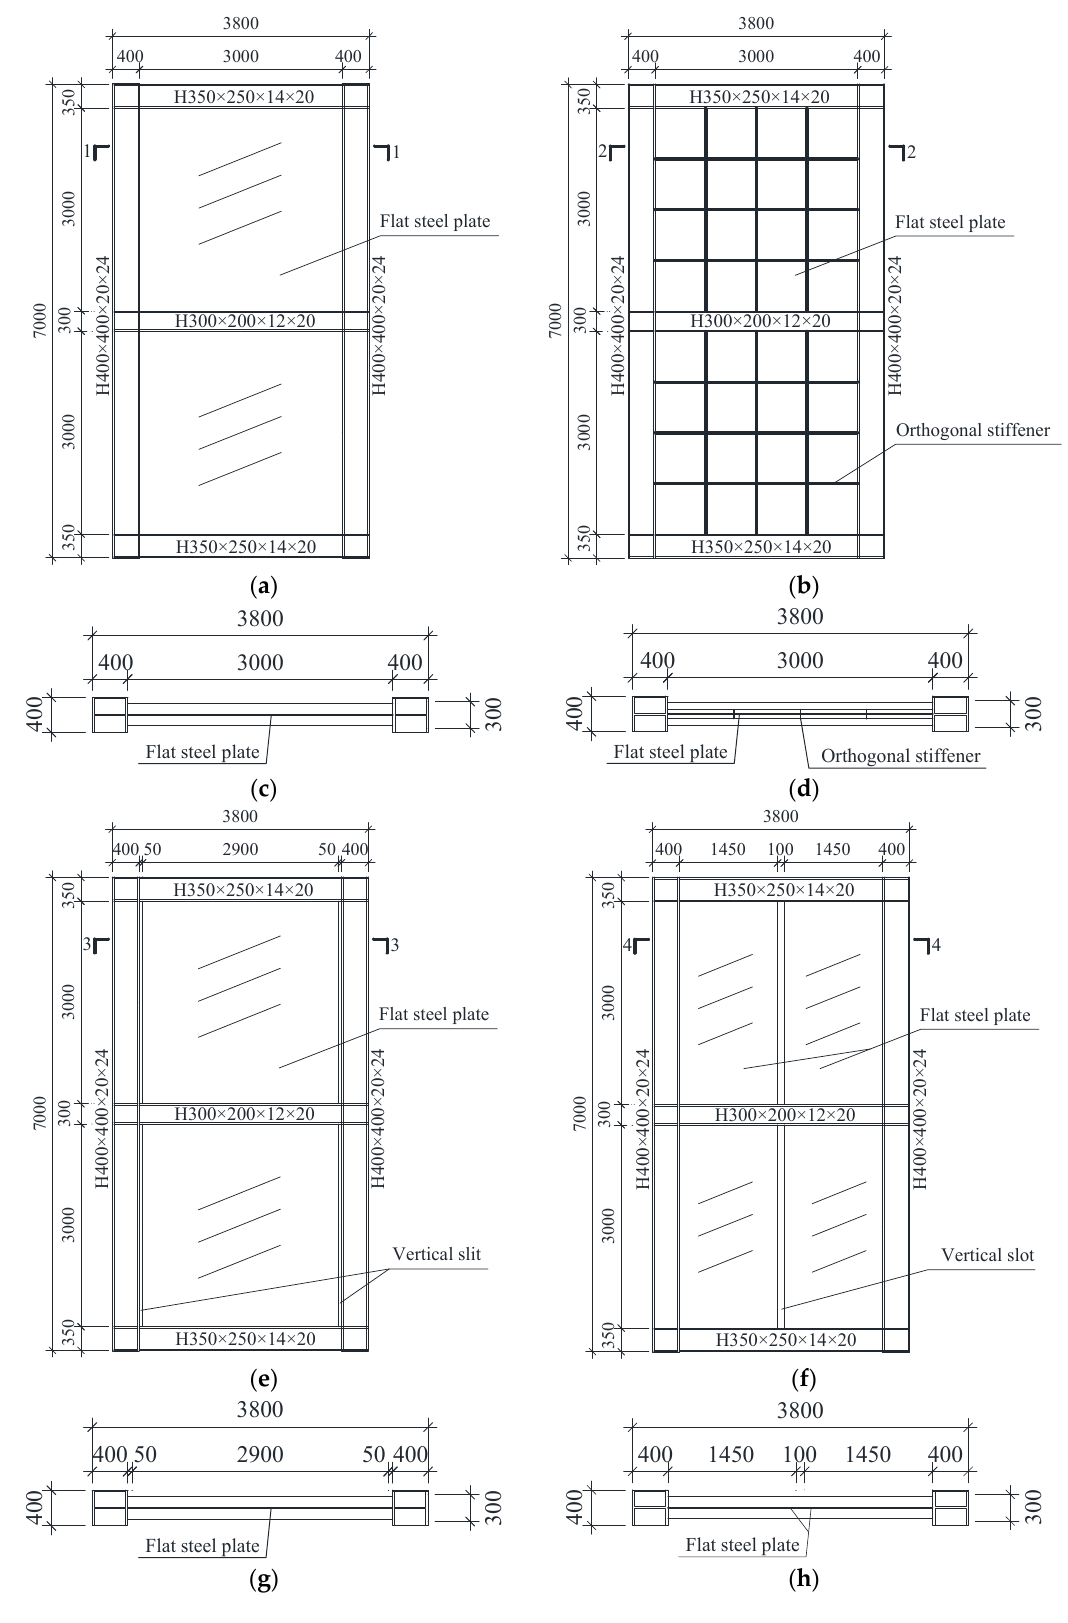
Figure 2. Dimension details of specimens: ( a ) FSPSW; ( b ) OSPSW; ( c ) Section 1-1 of FSPSW; ( d ) Section 2-2 of OSPSW; ( e ) BSPSW; ( f ) VSSPSW; ( g ) Section 3-3 of BSPSW; ( h ) Section 4-4 of VSSPSW.